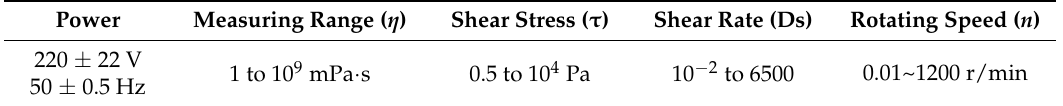
Table 3. Viscometer test indicators.